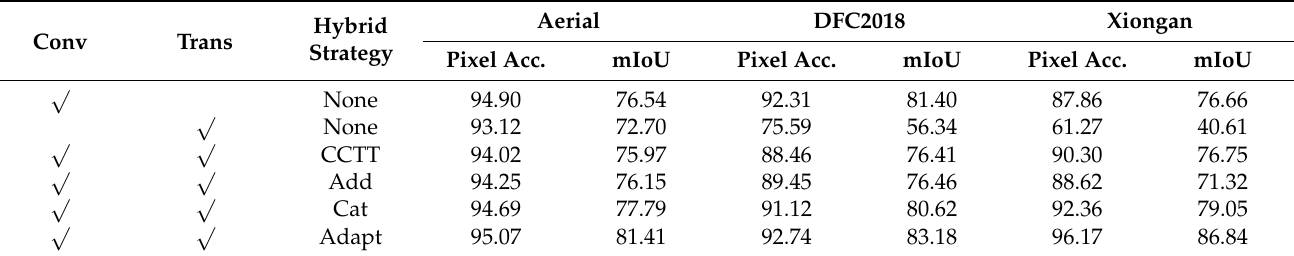
Table 8. Backbone network ablation experiment.